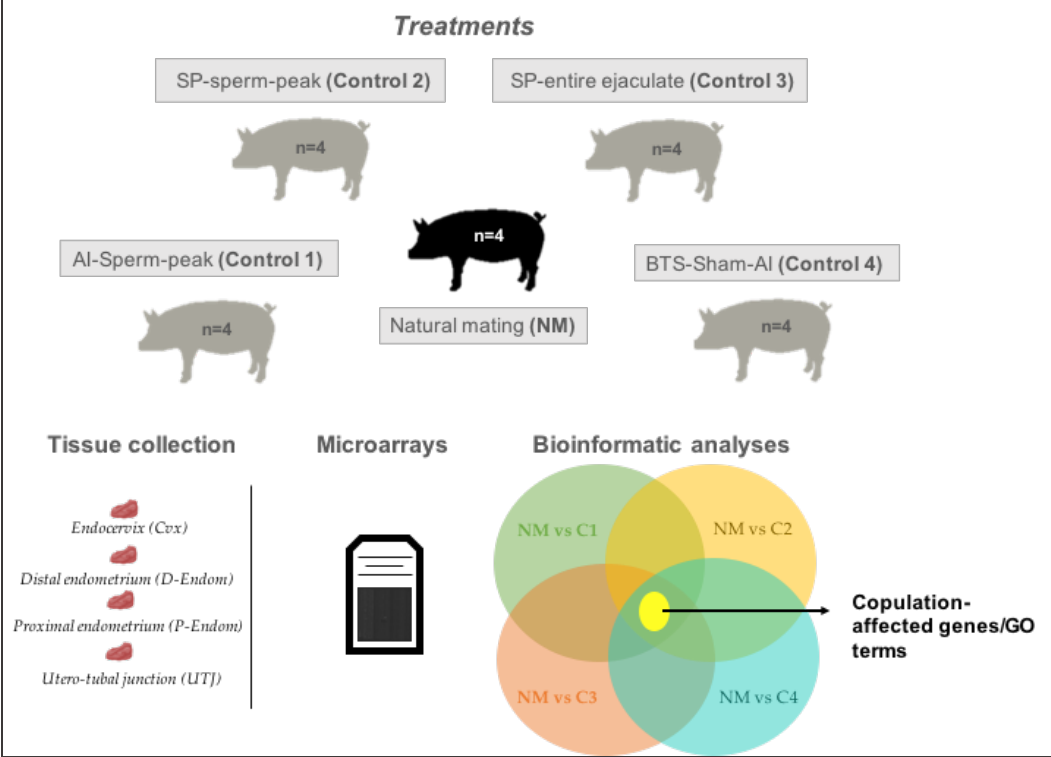
Figure 5. Graphical illustration of the experimental design. Experimental sow groups compared natural mating (NM) with cervical artificial insemination (AI) of semen of the sperm-peak fraction (control 1), of sperm-free SP from the sperm-peak fraction (control 2), of sperm-free SP from the whole ejaculate (control 3) or of saline BTS semen extender (control 4, sham–AI). Mucosal samples from the endocervix (Cvx), endometrium (distal: D-Endom or proximal: P-Endom) and the utero-tubal junction (UTJ) were surgically retrieved 24 h later and analyzed. NM was first compared to all experimental controls to isolate those DEGs not affected by semen, SP or AI-vagino-cervical stimulation, e.g., those being exclusively affected by copulation.